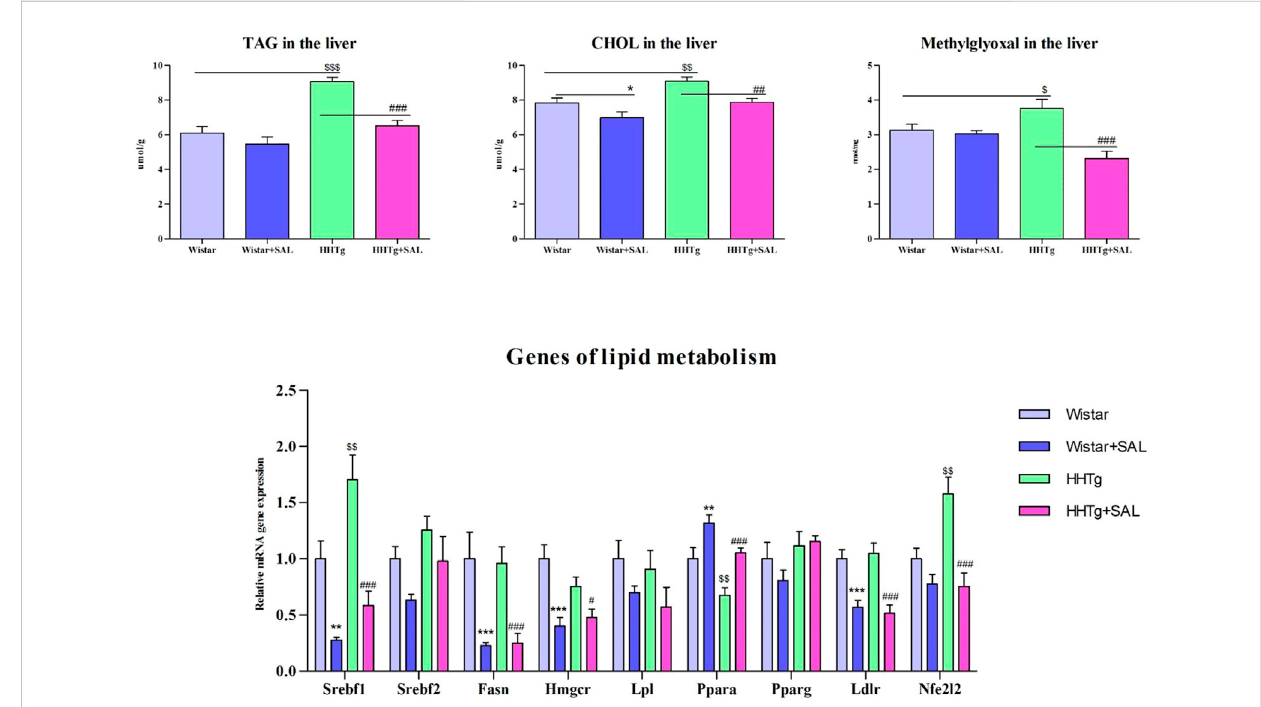
FIGURE 4 Effect of salsalate treatment on hepatic lipids and methylglyoxal accumulation and relative mRNA expression of enzymes and transcription factors involved of lipid metabolism in Wistar control and hereditary hypertriglyceridemic (HHTg) rats. Values are expressed as mean ± SEM; n = 8; *